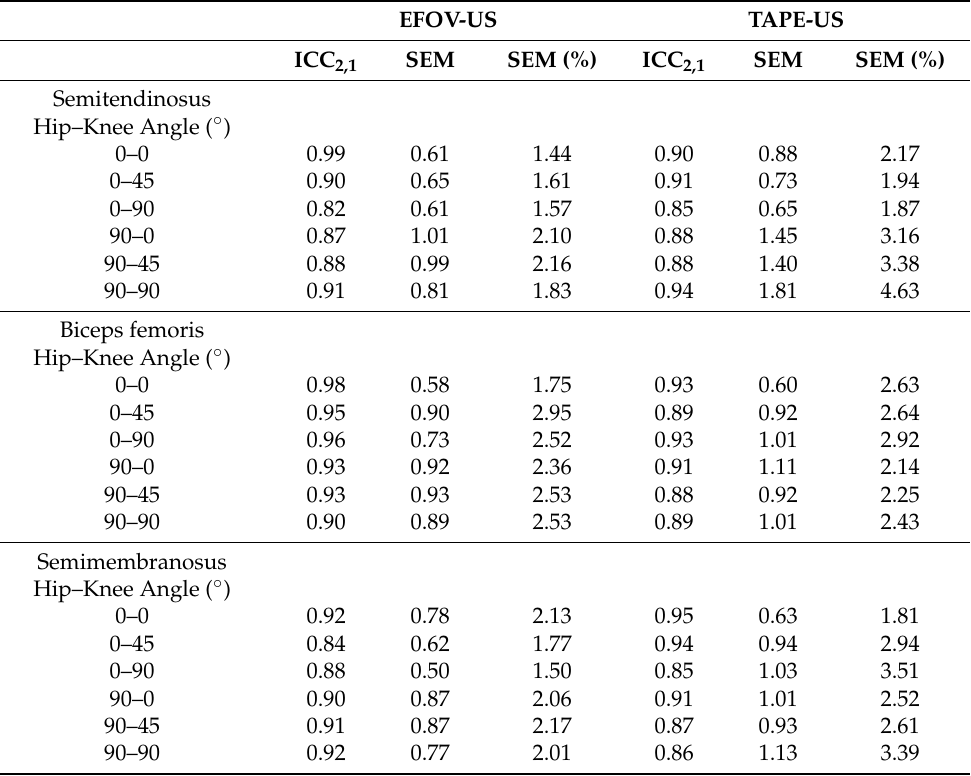
Table 1. Reliability values for length of each hamstring using extended field-of-view ultrasonography (EFOV-US) and the ultrasound tape (TAPE-US) method ( n =